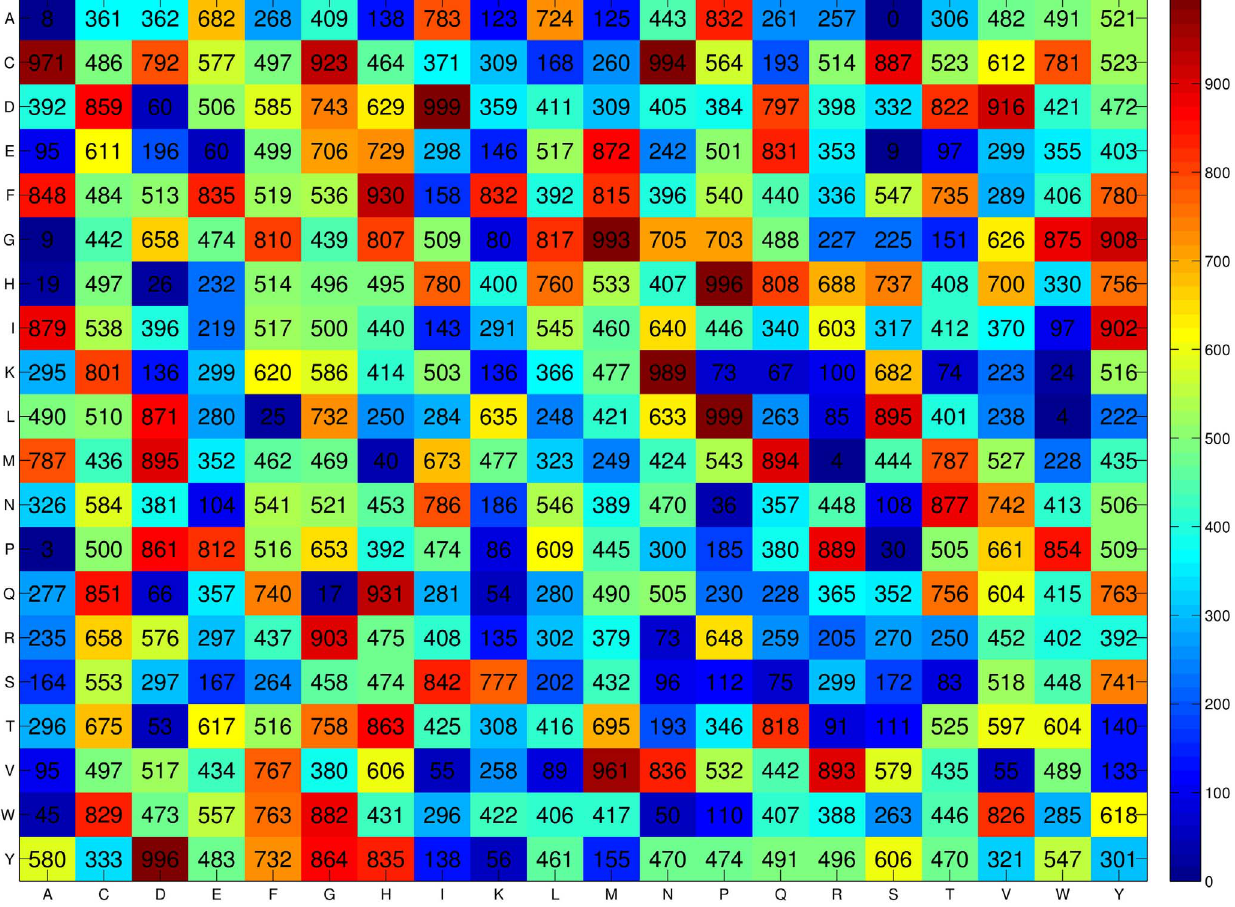
PLOS ONE | www.plosone.org